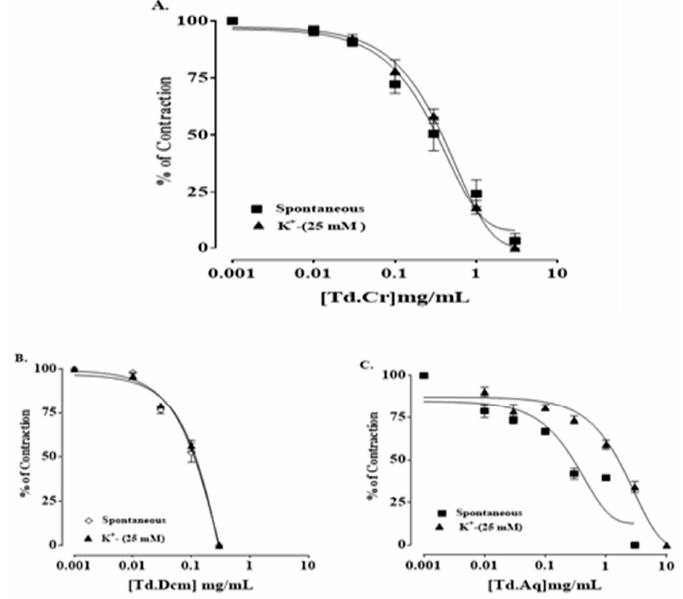
Figure 4. Concentration-response graphical presentation of ( A ) TdCr, ( B ) TdDcm, and ( C ) TdAq on natural and K+ (25 mmol/L) provoked contractions of isolated jejunal preparation. Values shown as mean ± SEM, n = 5.